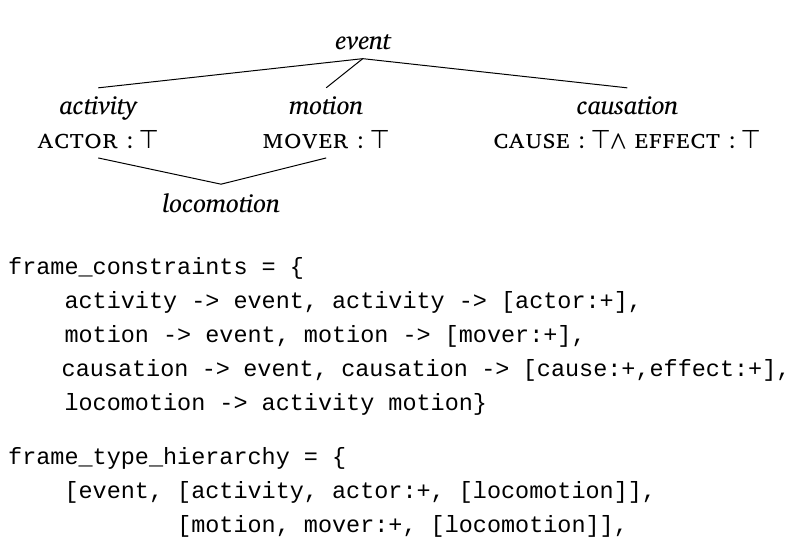
Figure 13: Examples of the specification of feature structure constraints. The type hierarchy is a fraction of the type hierarchy shown above in Figure 3 from Kallmeyer and Osswald